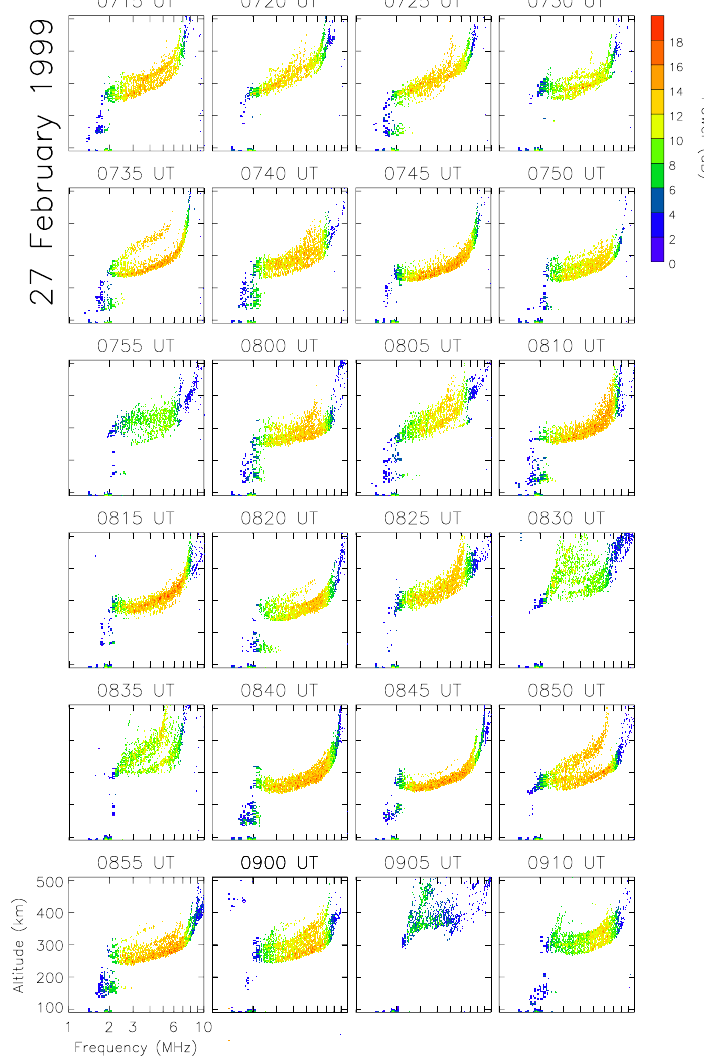
Fig. 4. A sequence of 24 ionograms from the Longyearbyen ionosonde, covering the interval over which polar patches A, B, and C were observed by the